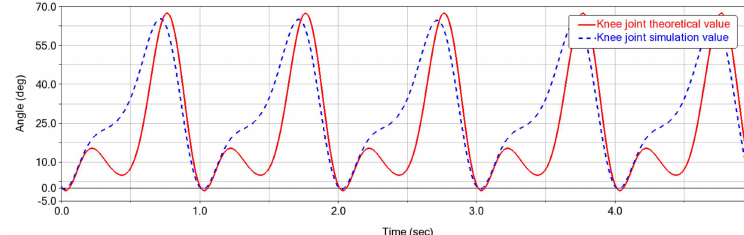
Figure 23. Knee angle variation chart.